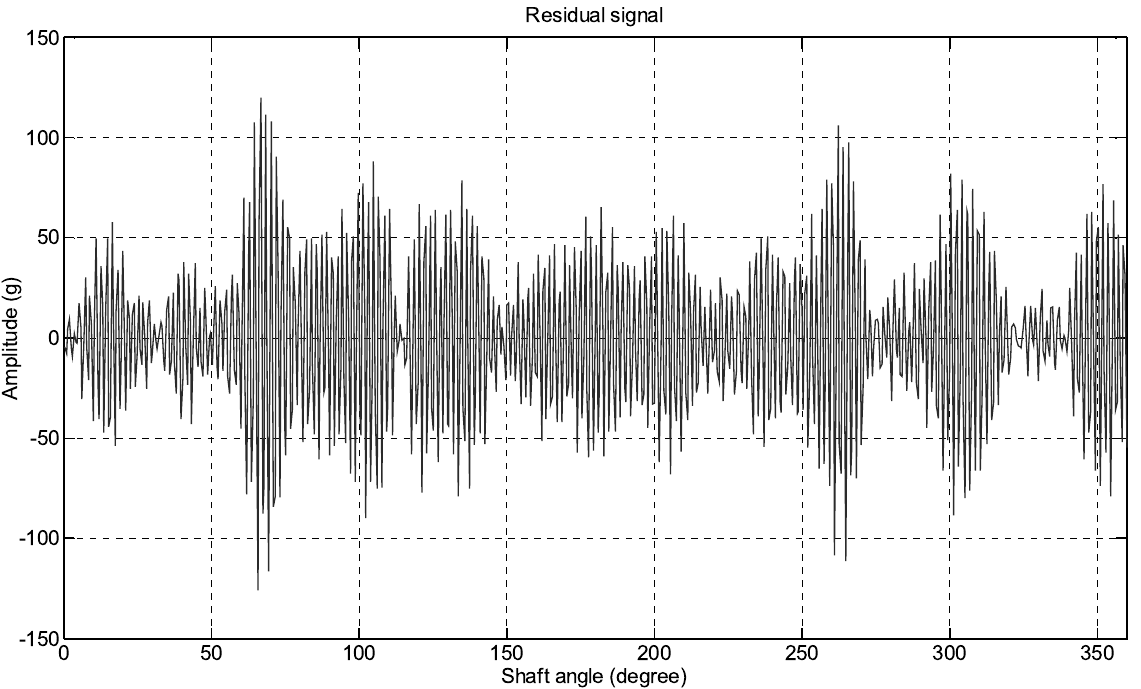
Fig. 13. Residual signal in the time